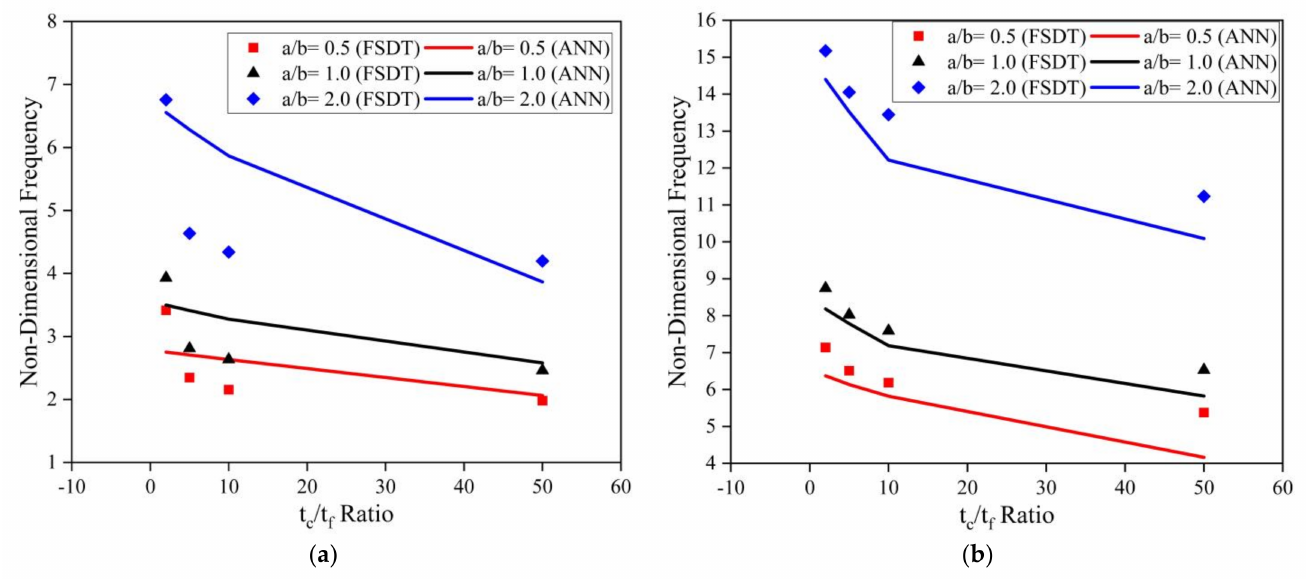
Figure 14. Influence of the t c /t f ratio on the clamped LCS plate in the presence of ( a ) temperature (400 K) and ( b ) moisture (1.0%) for varying a/b ratios.